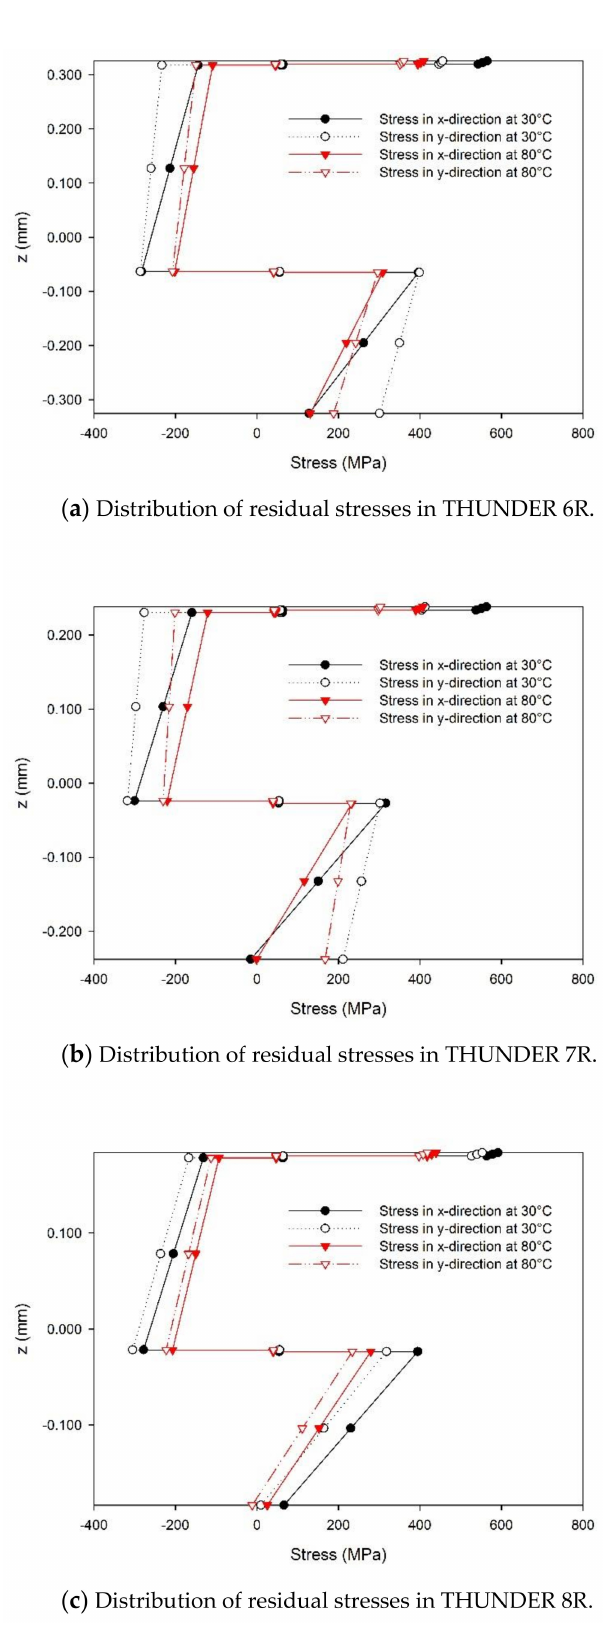
Figure 4. Residual stresses in various THUNDER devices. ( a ) Distribution of the residual stresses in THUNDER 6R. ( b ) Distribution of residual stress of THUNDER 7R. ( c ) Distribution of residual stress of THUNDER